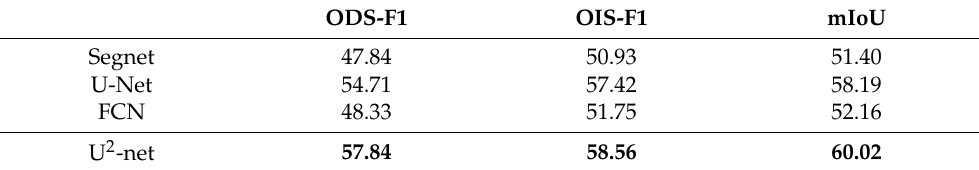
Table 2. Experimental results on the Nanjing dataset with semantic segmentation models.